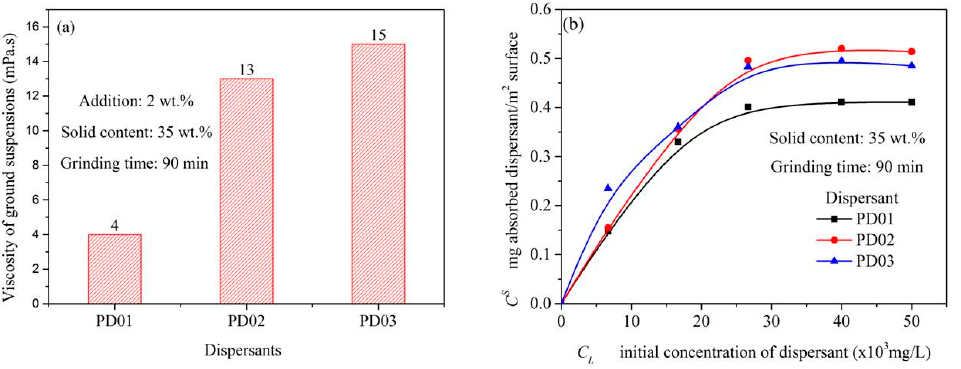
Figure 7. ( a ) Viscosity of the S-ZnF particles ground in the presence of different dispersants (PD01, PD02, and PD03) at 2 wt.% addition; ( b ) adsorption curves of the S-ZnF particles ground in the presence of different dispersants (PD01, PD02, and PD03).